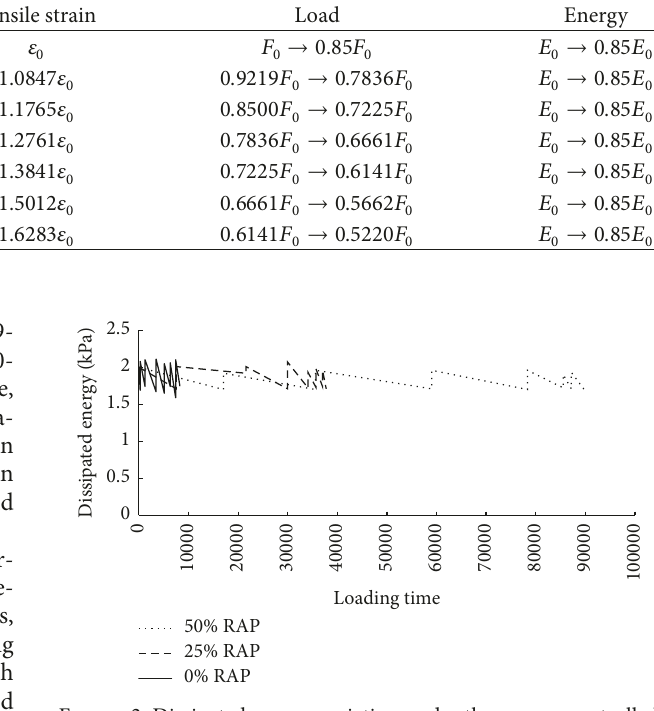
Figure 2: Dissipated energy variation under the energy-controlled mode at 15 ∘ C.